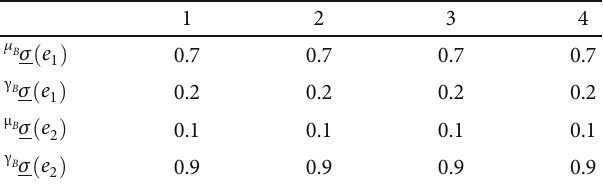
Table 21: Lower approximation of B .